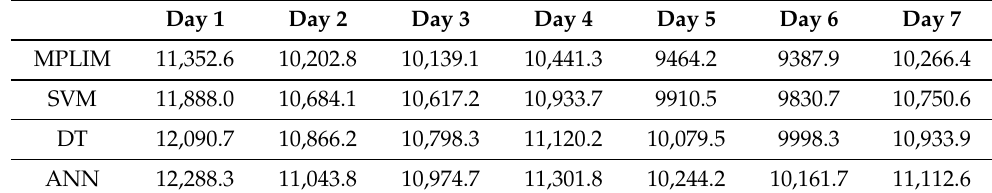
Table 3. Comparison of daily energy losses results in KWh.